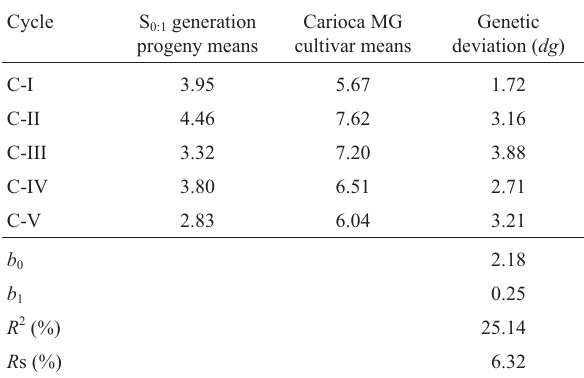
Table 5 - The S 0:1 generation progeny means from the first to the fifth recurrent selection cycle (C-I to C-V), the Carioca MG cultivar means, the genetic deviation ( dg ) for the Carioca MG cultivar ( i.e. the Carioca MG cultivar mean minus the progeny mean), the intercept ( b 0 ), linear regression ( b 1 ) and determination ( R 2 ) coefficients and the response to selection ( Rs ) for the angular-leaf-spot severity score (1-9). Cycle